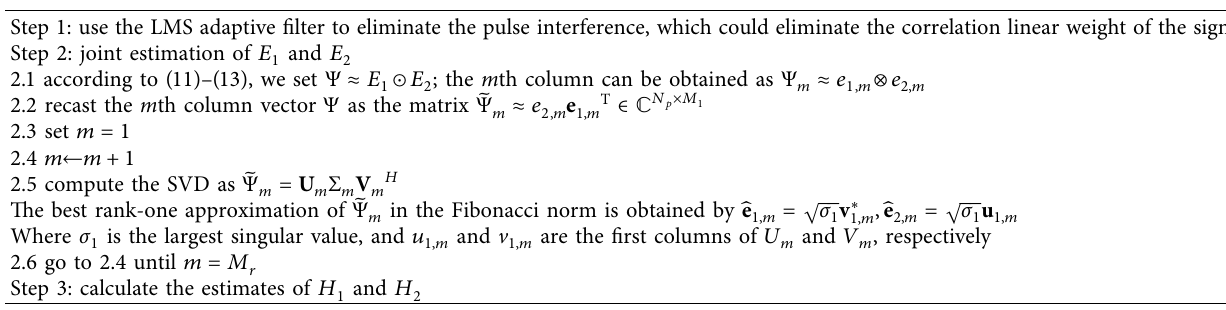
Table 2: Te PIC-OPT